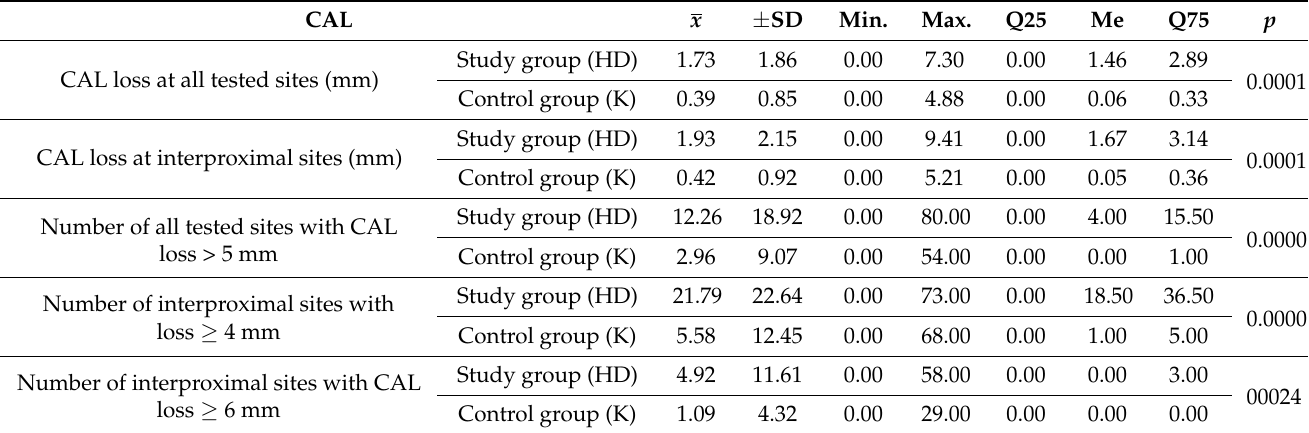
Table 5. Mean clinical attachment level (CAL) values in the study groups.